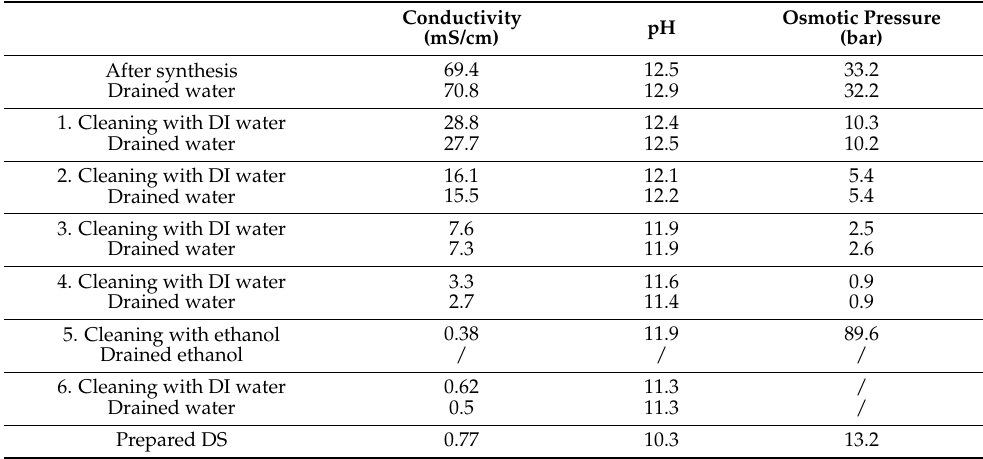
Table 2. Conductivity, pH and osmotic pressure values of Fe 3 O 4 @CA MNPs after synthesis and washing